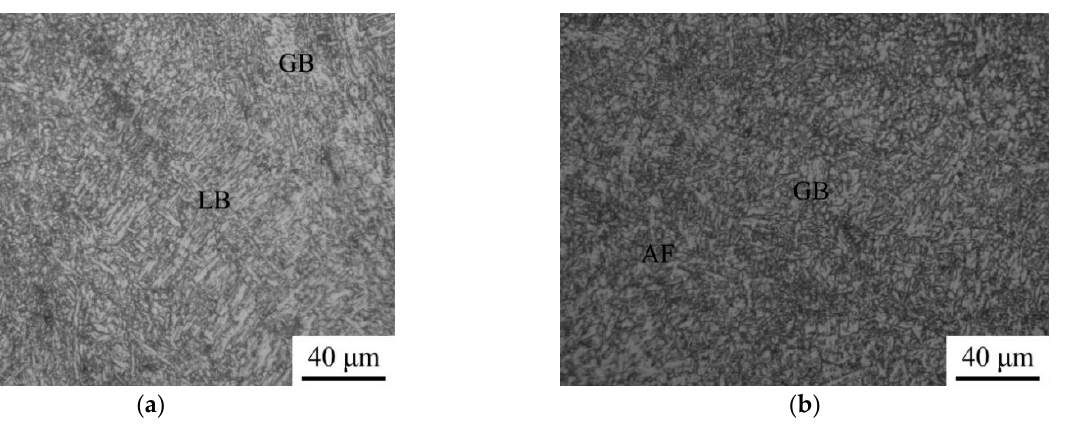
Figure 8. Metallographic microstructure of weld metal under different arc lengths. Arc length: ( a ) 2.9 mm; ( b ) 9.2 mm.